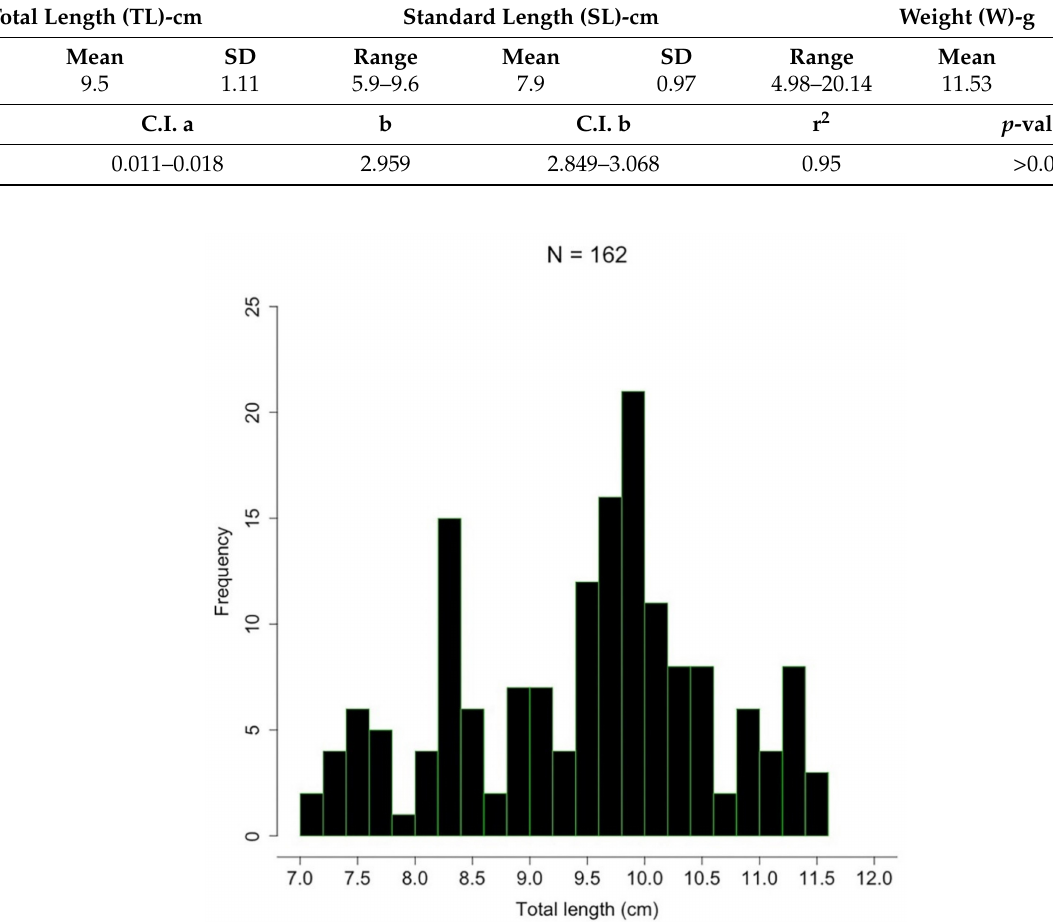
Figure 3. Size distribution (TL in cm) of sampled specimens of G. paganellus .